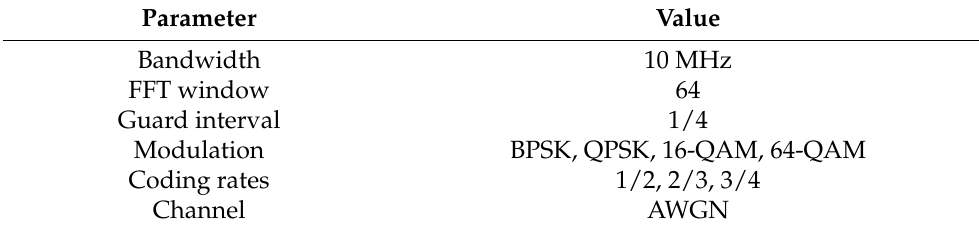
Table 1. Parameters used in the IEEE 802.11p PHY